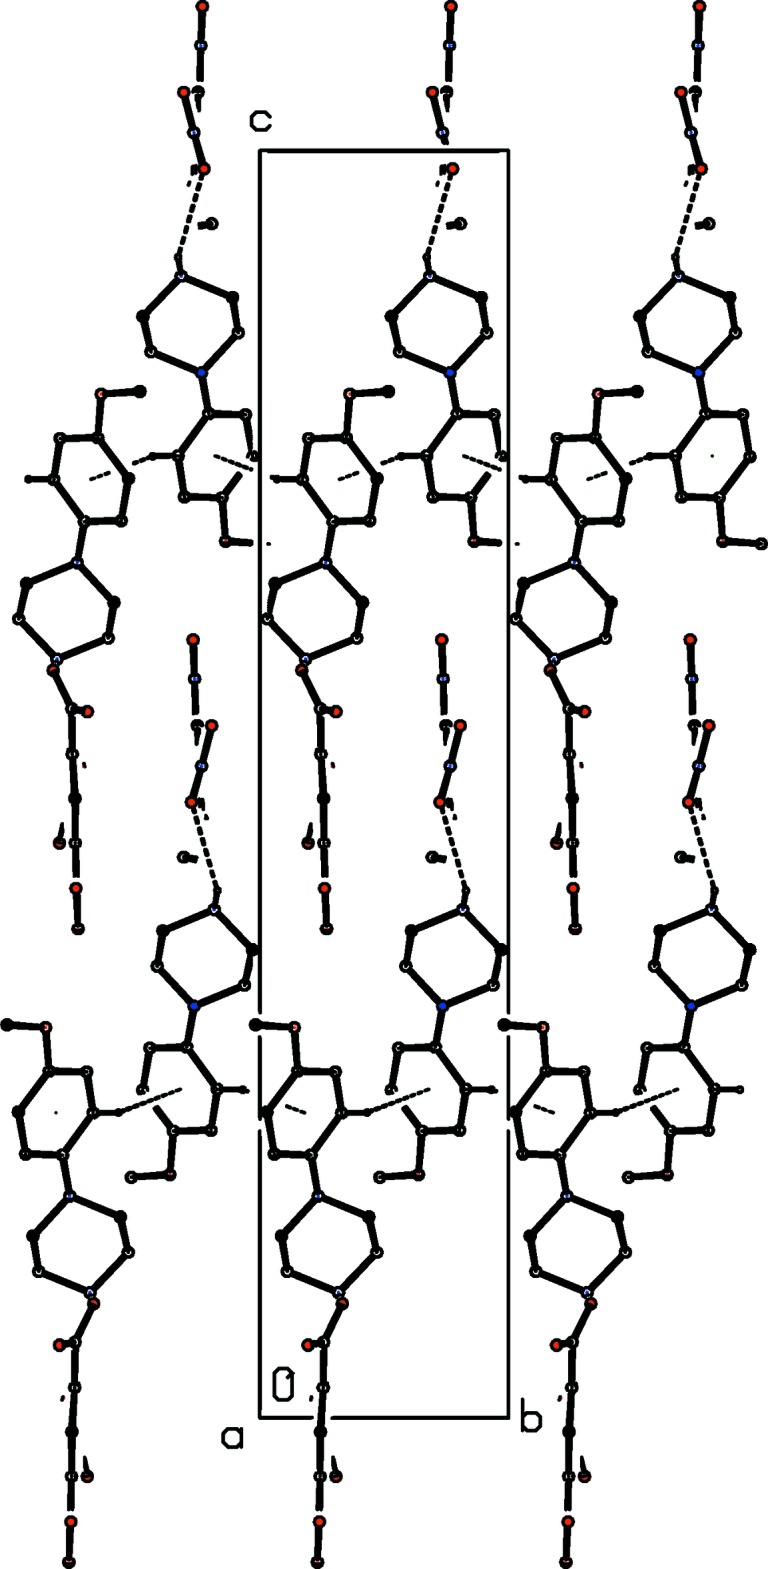
A projection along [100] of part of the crystal structure of (III), showing the inter­digitation of the sheets lying parallel to (001). Hydrogen bonds are drawn as dashed lines and, for the sake of clarity, the minor disorder components and the H atoms not involved in the motifs shown have been omitted.